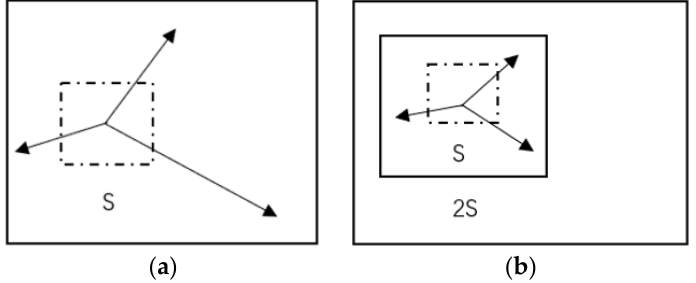
Figure 3. The K-means method is used to generate superpixel cells, while maintaining the relevance of pixel texture, the traversal speed is also guaranteed [36]. Ordinary k-means ( a ) and parallel k-means in the limited areas ( b ) .